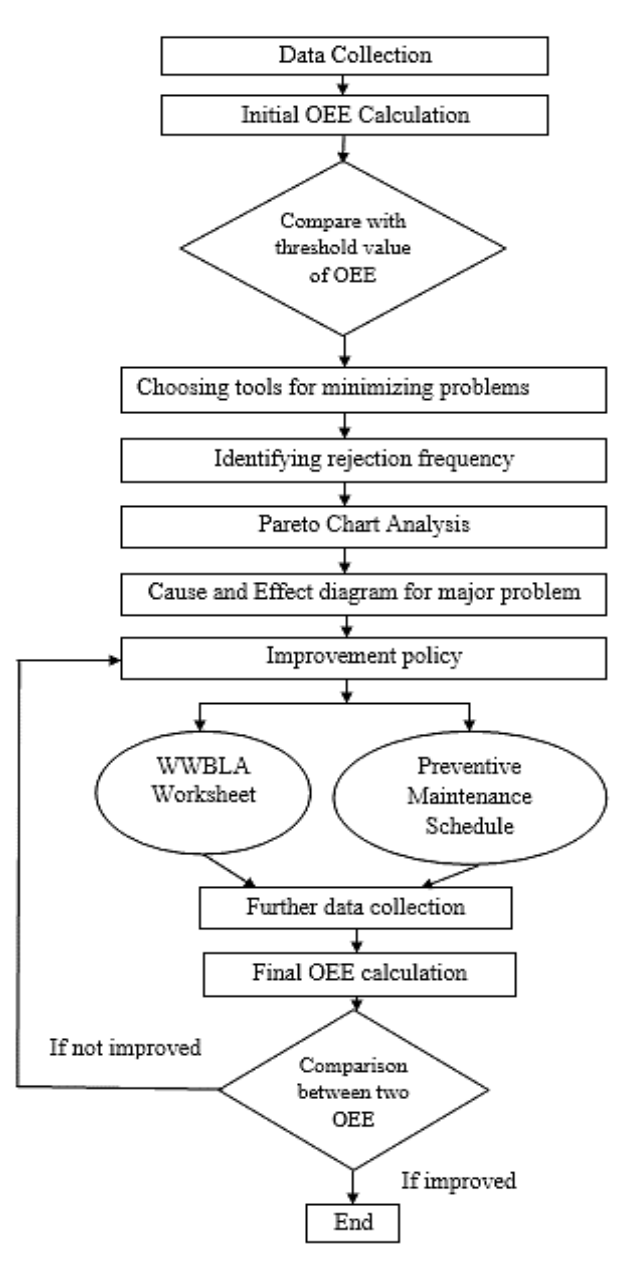
Figure 1. Process flow diagram of